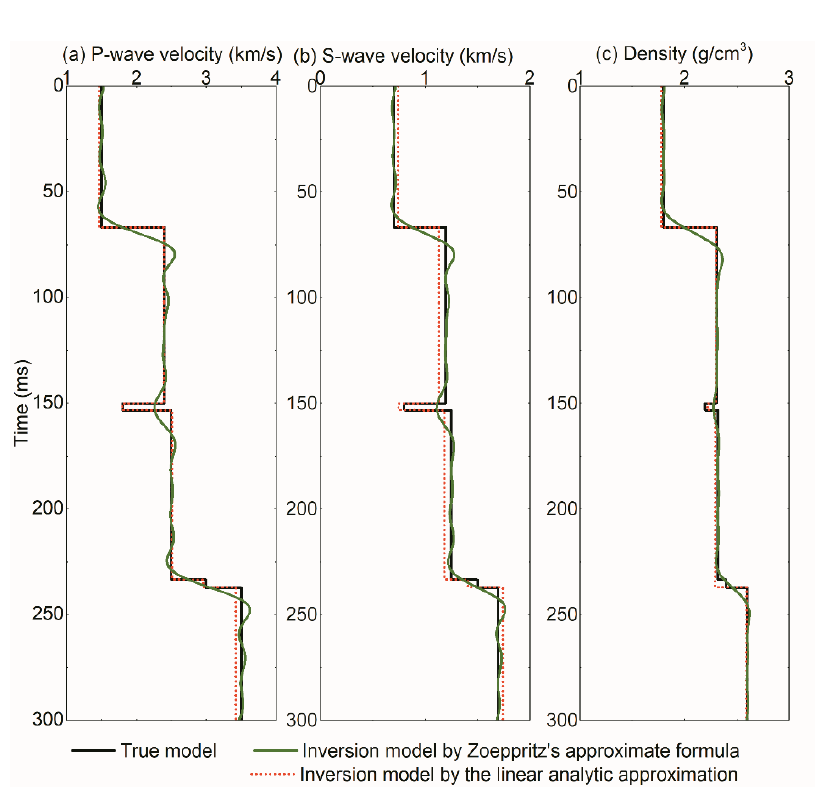
Figure 11. Inversion results of Model 5 by the linear analytic approximation and Zoeppritz’s Figure11. InversionresultsofModel5bythelinearanalyticapproximationandZoeppritz’sapproximate formula: ( a ) P-wave velocity; ( b ) S-wave velocity; ( c ) approximate formula: ( a ) P-wave velocity; ( b ) S-wave velocity; ( c ) density.